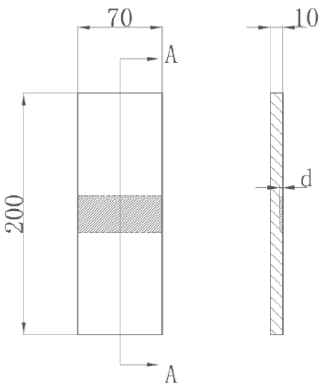
Figure 1. Varestraint test board production base material (mm).